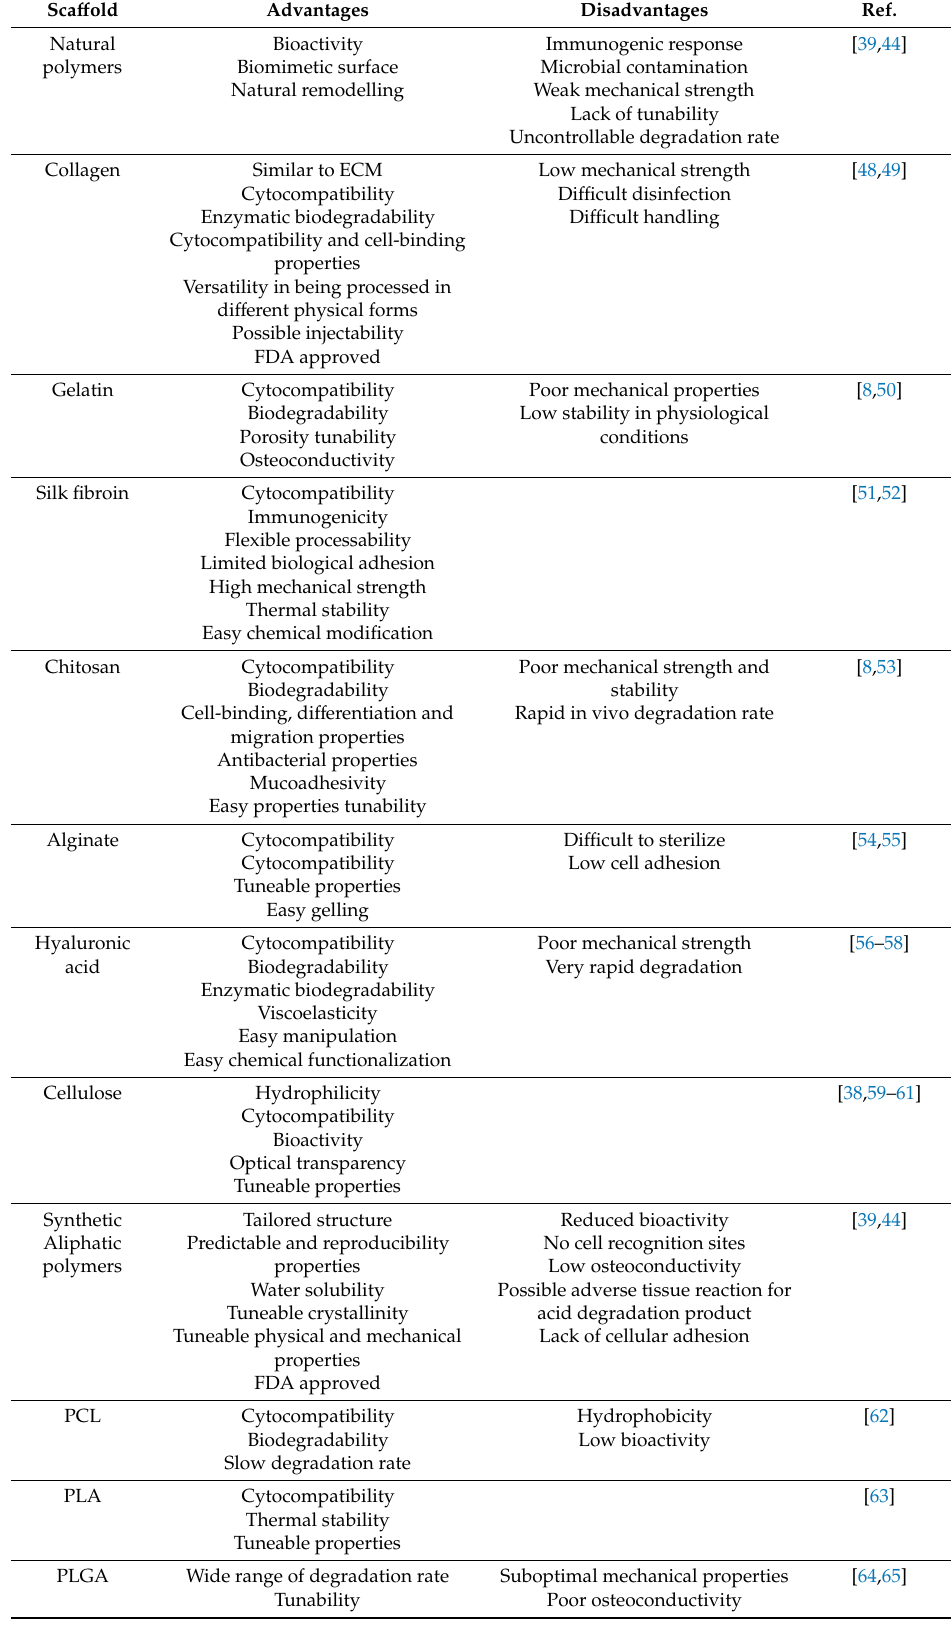
Table 4. Natural and synthetic polymeric materials suitable for bone tissue regeneration and their main